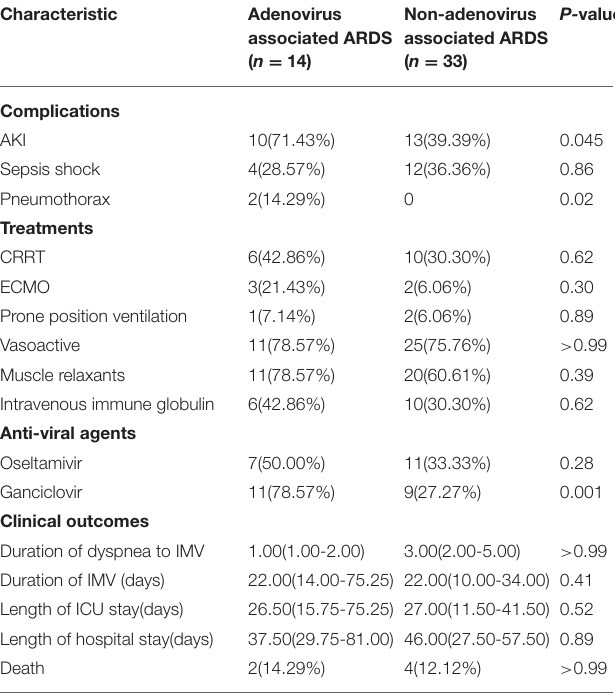
TABLE 4 | Complications, treatments, and clinical outcomes in patients with adenovirus-associated ARDS.